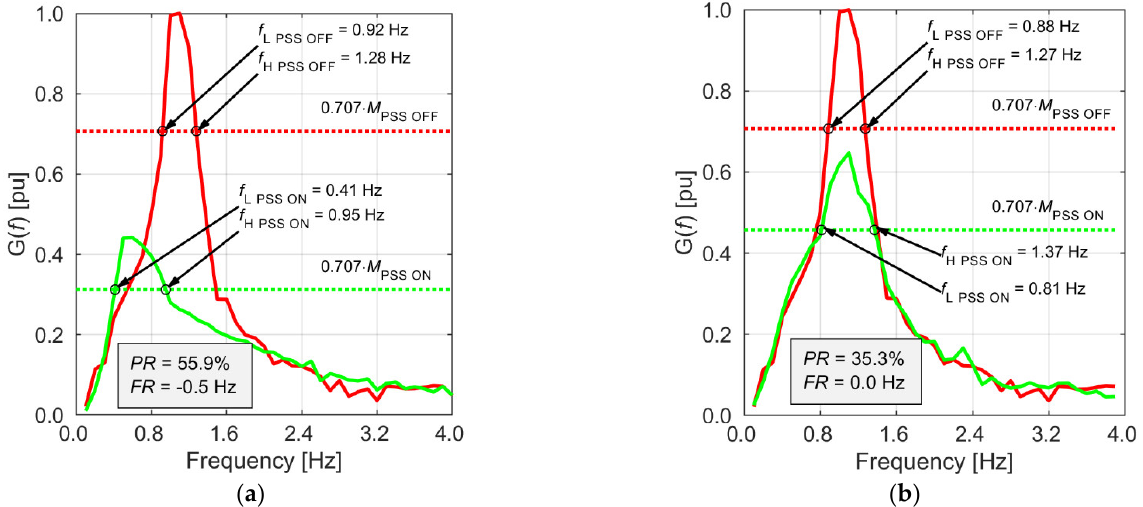
Figure 13. G PSS OFF ( f ) and G PSS ON ( f ) for two sets of the PSS settings ( a , b ) under the following test conditions: PSS is OFF/ON, P g = 140 MW, Q g = 0 Mvar [40]. conditions: PSS is OFF/ON, P g = 140 MW, Q g = 0 Mvar [40].